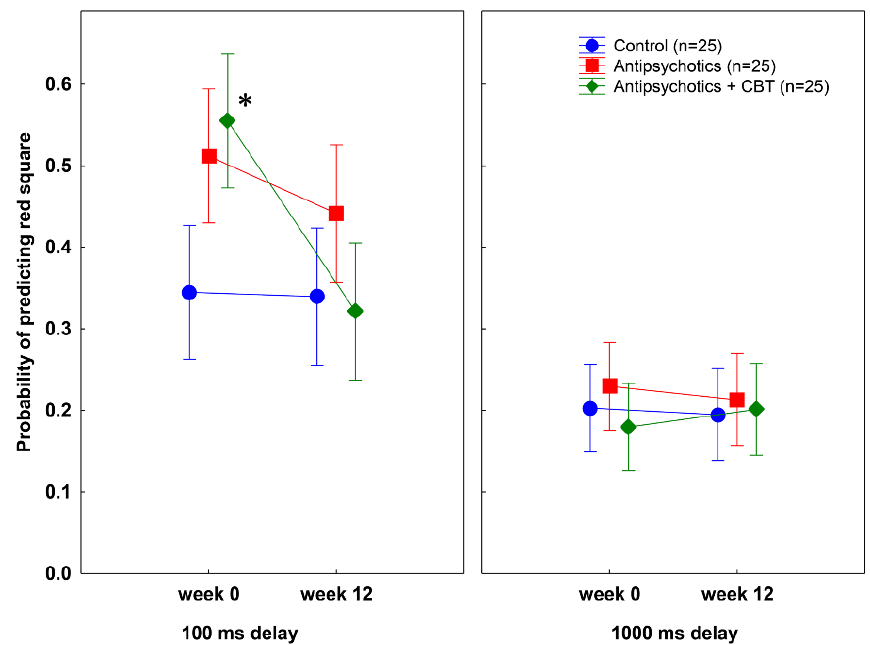
Figure 2. Mean probabilities of predicting the red square at each delay (100 ms and 1000 ms) at weeks 0 and 12. Error bars indicate 95% confidence intervals. At week 0, patients with schizophrenia achieved higher postdiction scores than controls when the delay was short (100 ms) (* antipsychotics vs. control: p = 0.04; antipsychotics plus CBT vs. control: p = 0.003, Tukey’s test) but not when it was long (1000 ms). At week 12, there was no significant difference between patients and controls. A significant drop in postdiction during the 12-week treatment phase was observed only in patients who received combined antipsychotic treatment and cognitive-behavioral therapy (CBT) (week 0 vs. 12, 100 ms delay, p =